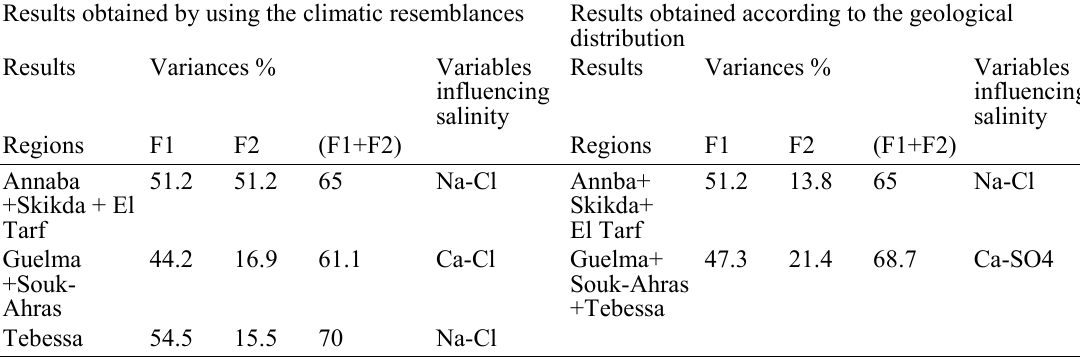
Table 2 Results of the principal analyses.